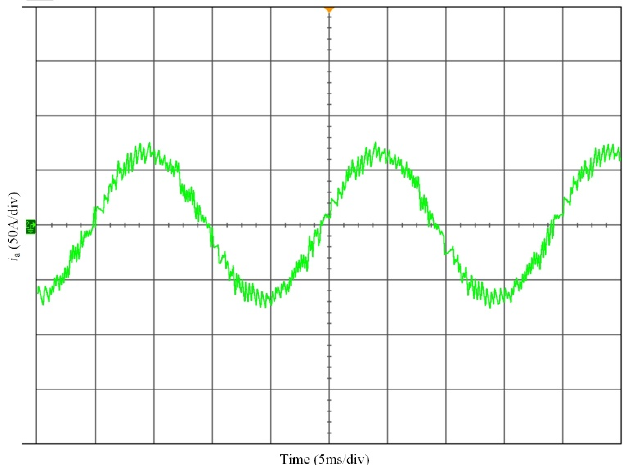
Figure 12. The curve of phase current for the conventional MPDTC.